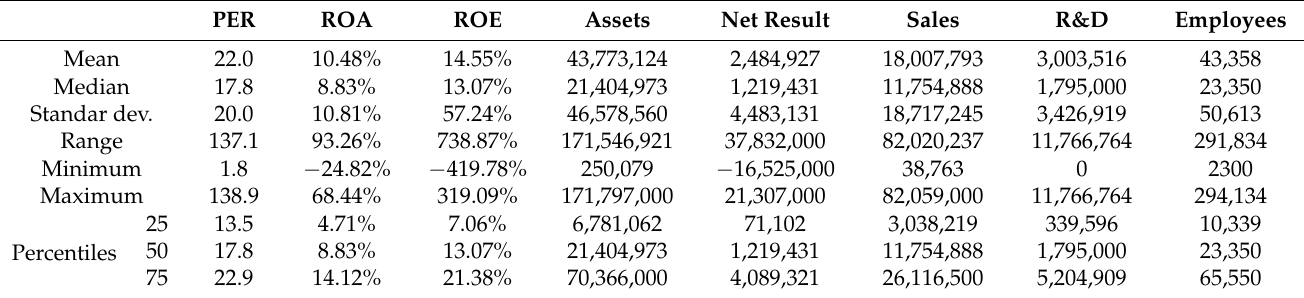
Table 2. Descriptive statistics of the world’s pharmaceutical firms’ top